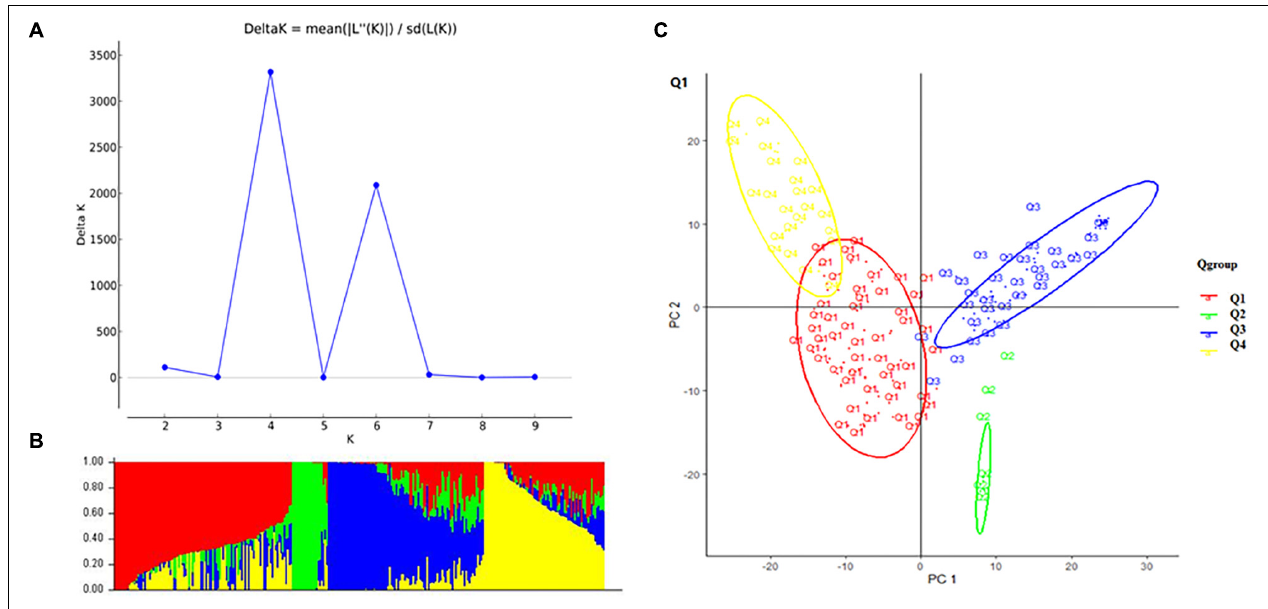
FIGURE 2 | Structure analysis: (A) delta K -values for different numbers of populations (K) from the STRUCTURE analysis, the x -axis shows different numbers of populations (K), the y -axis shows delta K -values for different numbers of subpopulations (K). (B) Classification of 284 accessions into four subpopulations using STRUCTURE version 2.3.4, where the x -axis shows accessions and the y -axis shows the probability (from 0 to 1) of each accession belonging to subpopulation (Q = K) membership. The membership of each accession belonging to subpopulations is indicated by different colors (Q1, red; Q2, green; Q3, blue; and Q4, yellow). (C) Principal component analysis (PCA) of the population structure. Distribution of the accessions in the association panel under PC1 and PC2.